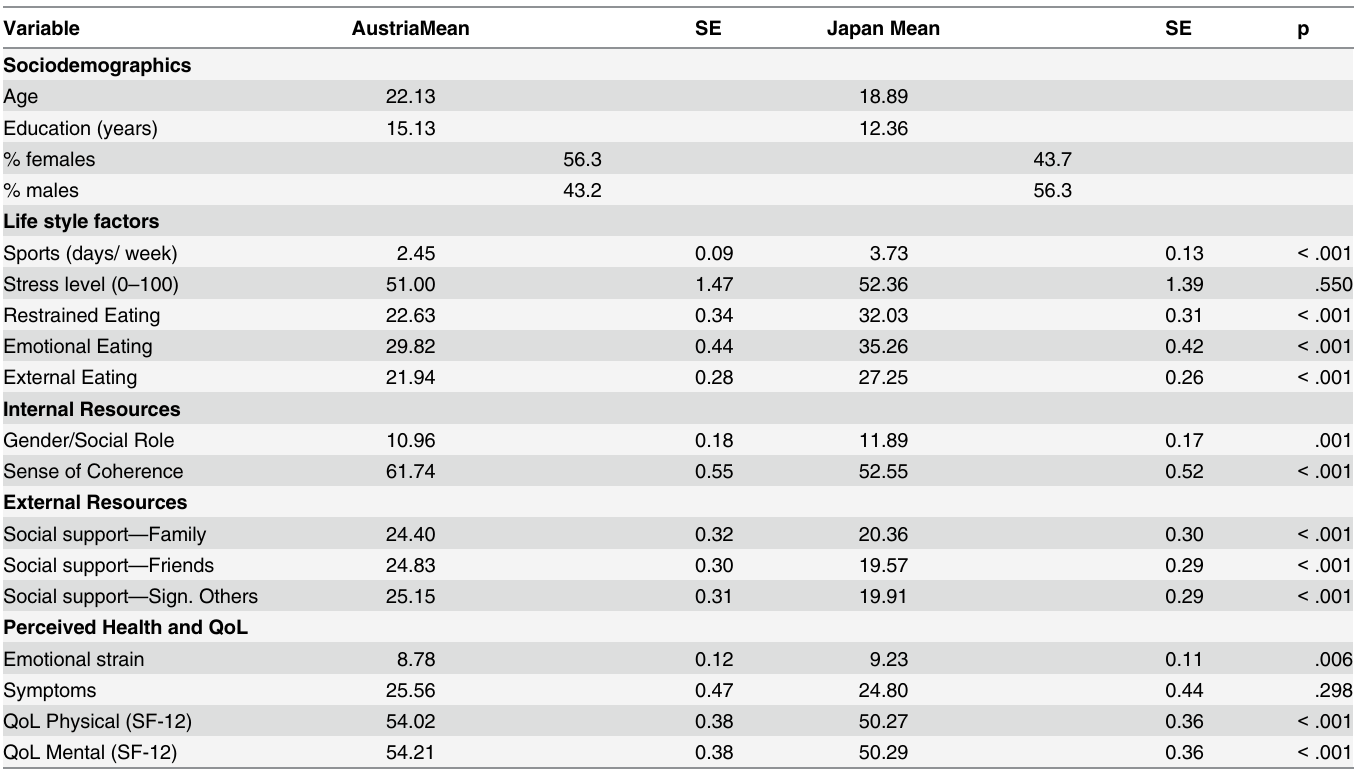
Table 1. Characteristics of